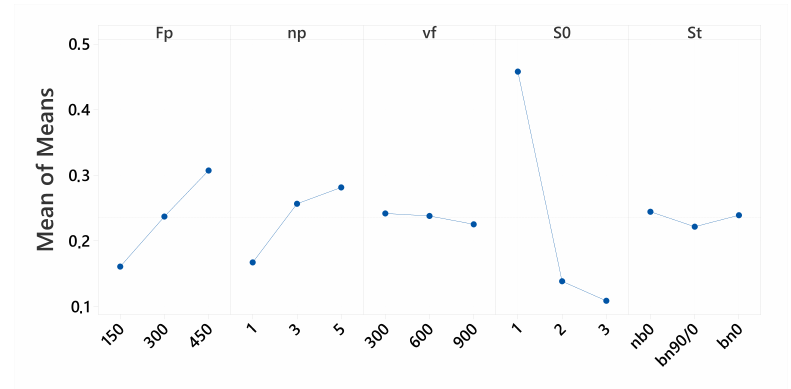
Figure 6. Mean effects graph derived from ANOVA considering the improvement ratio of S q with regard to the original value (1 − S q / S 0 q ).